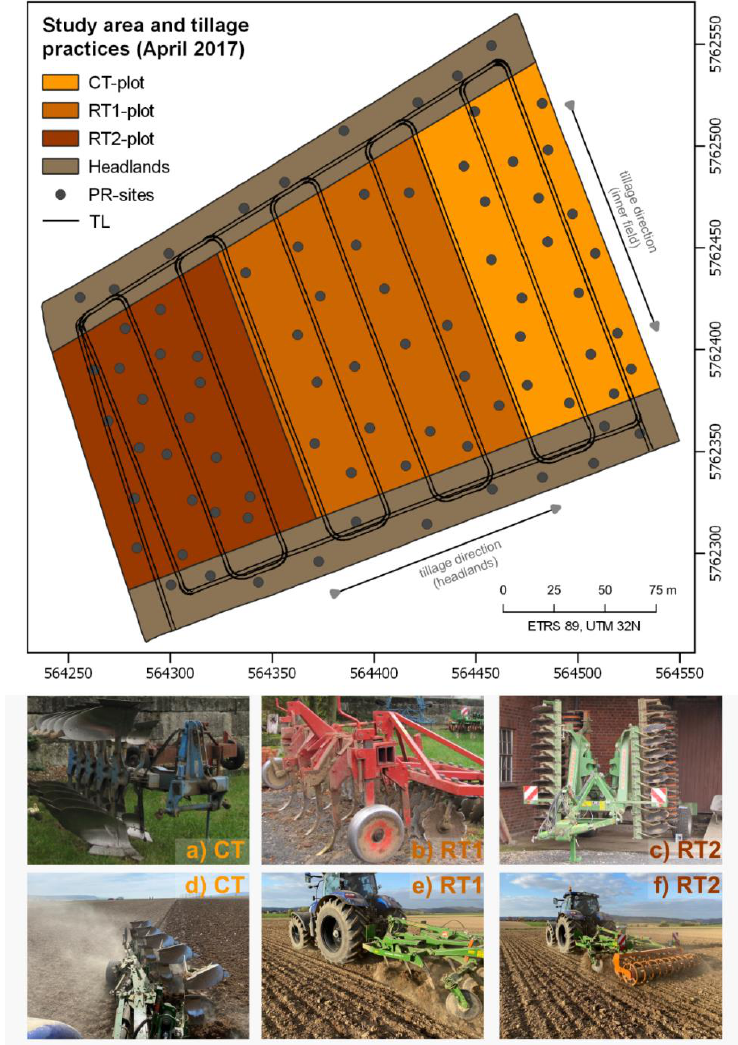
Figure 1. Study area with the plots separated by different tillage practices and the headlands (April 2017). CT: continuously conventional tilled plot; RT1: reduced tilled plot (chisel plough), affected by one-time inversion tillage; RT2 reduced tilled plot (disc harrow), affected by one-time inversion tillage; PR-sites: Sites of penetration resistance measurements. TL: Tramlines. Photographs ( a – c ) show the tillage implements of 2014 and 2015, photographs ( d – f ) the tillage implements for 2016–2019.